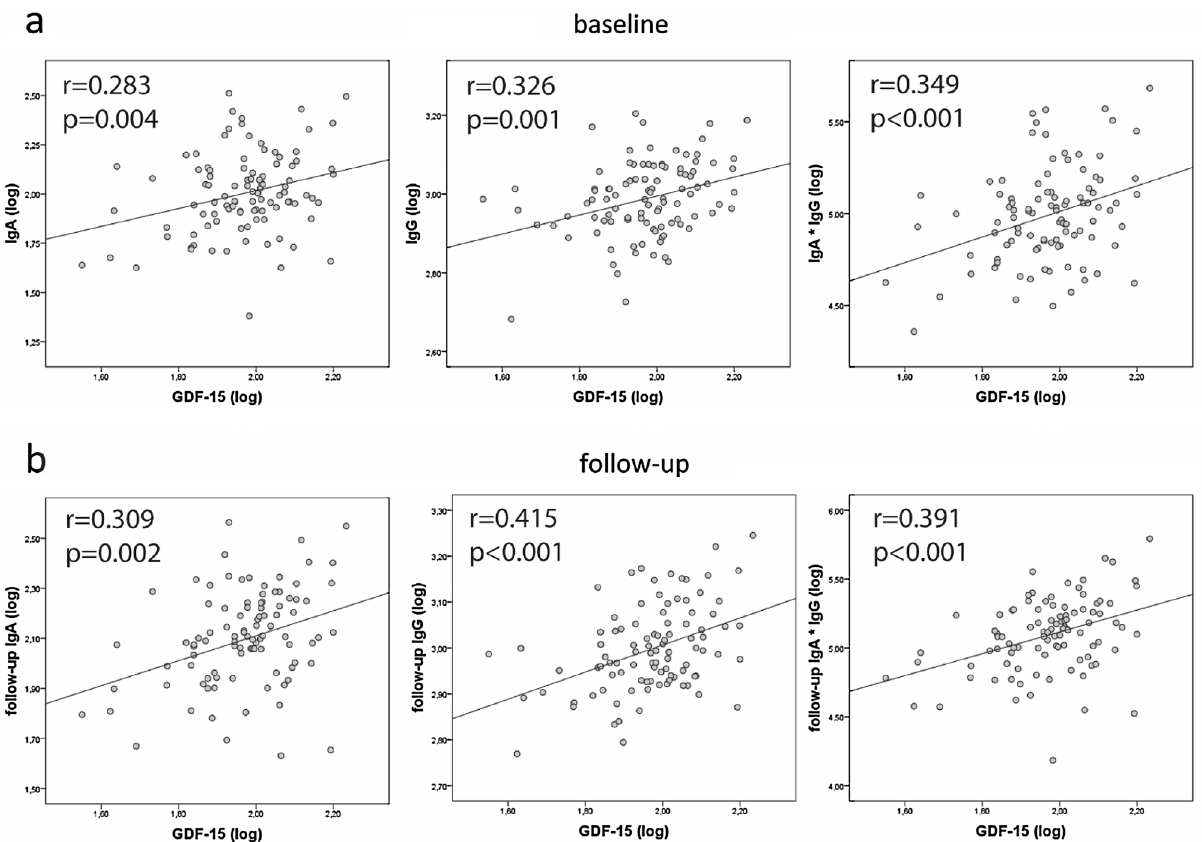
Figure 1. Correlation graphs between circulating GDF-15 and the studied IgA, IgG and IgA*IgG product in children with higher renal fat-to-height ratio (above the median; N = 102). ( a ) At baseline: 9 years of age and ( b ) at follow-up: 13 years of